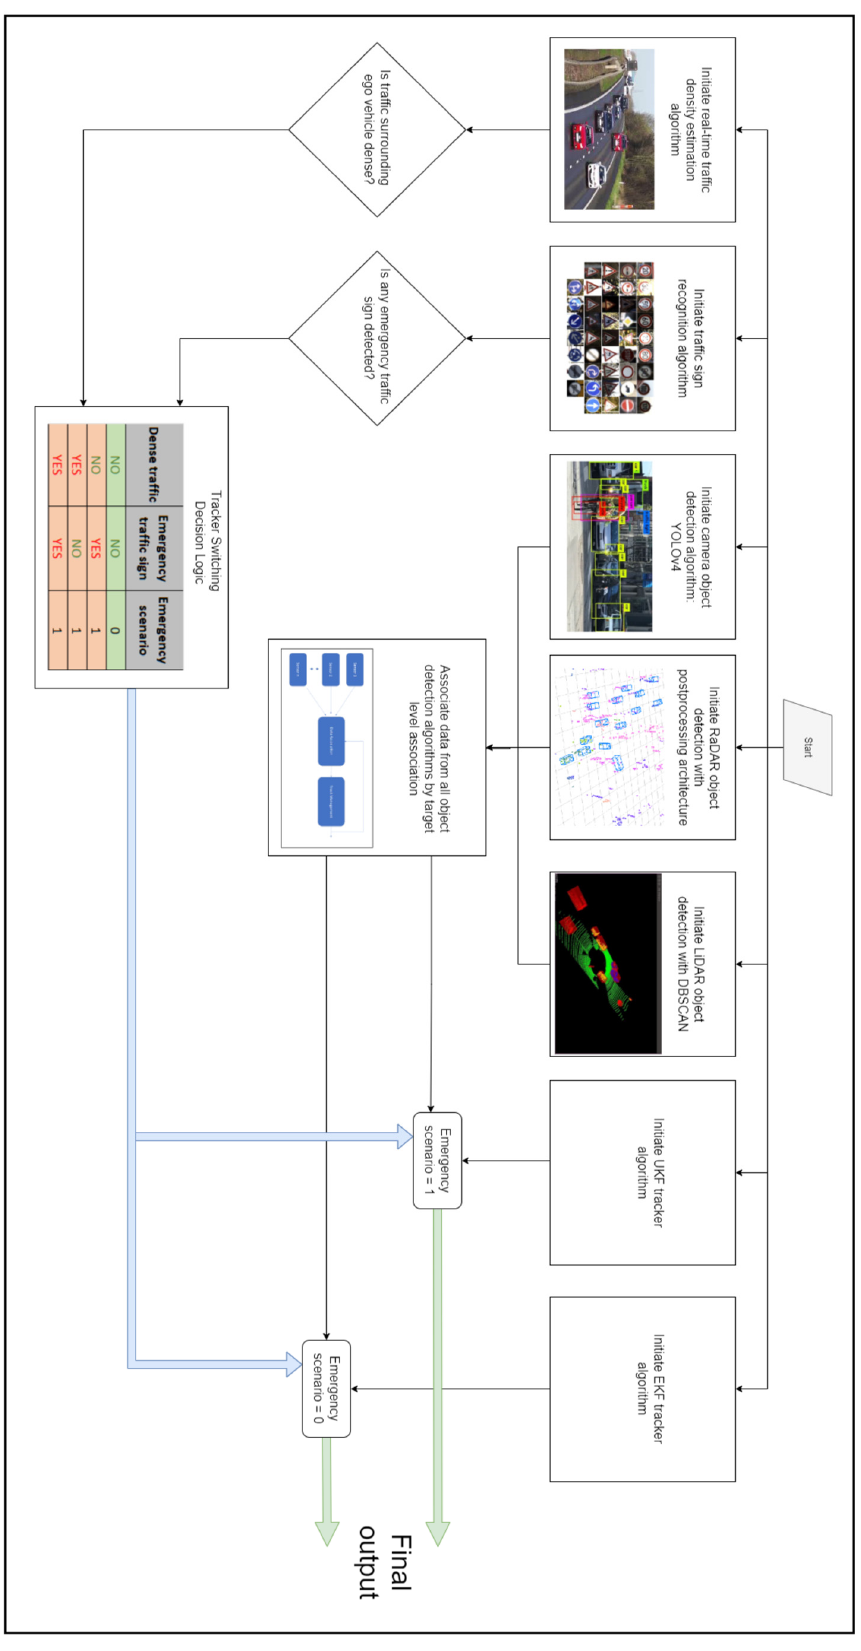
Figure 17. Architecture of proposed fusion logic with tracker switching.